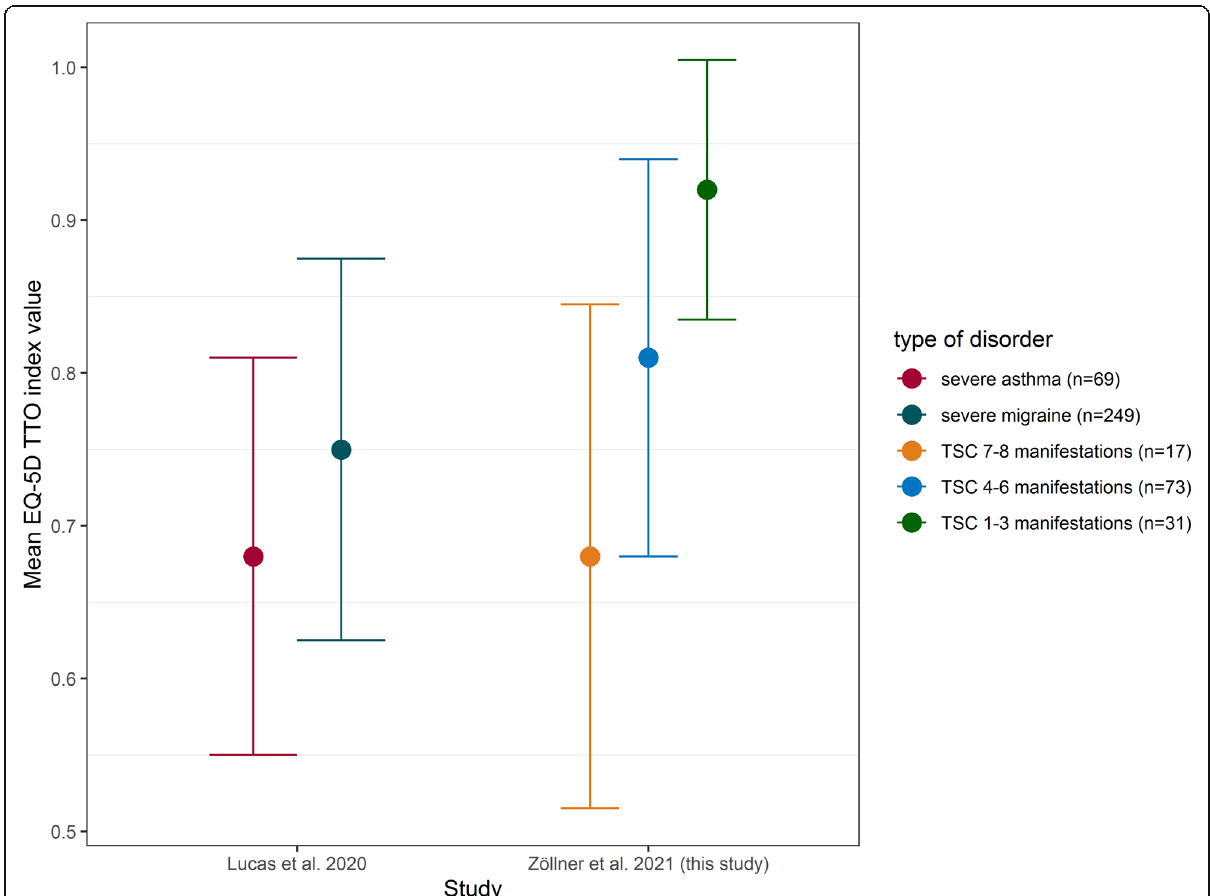
Fig. 3 Generic quality of life (EQ-5D) among TSC patients compared with patients with other chronic disorders. Comparison of quality of life (QoL), as assessed by the EuroQoL-5 dimensions (EQ-5D), between a study (Lucas et al., [38]) including 69 patients with severe asthma and 249 patients with severe migraine and our cohort of tuberous sclerosis complex (TSC) individuals, stratified by the number of TSC manifestations. A large difference in QoL between lightly and more severely affected TSC individuals is evident, with more severely affected individuals exhibiting QoL similar to patients with other severe chronic disorders